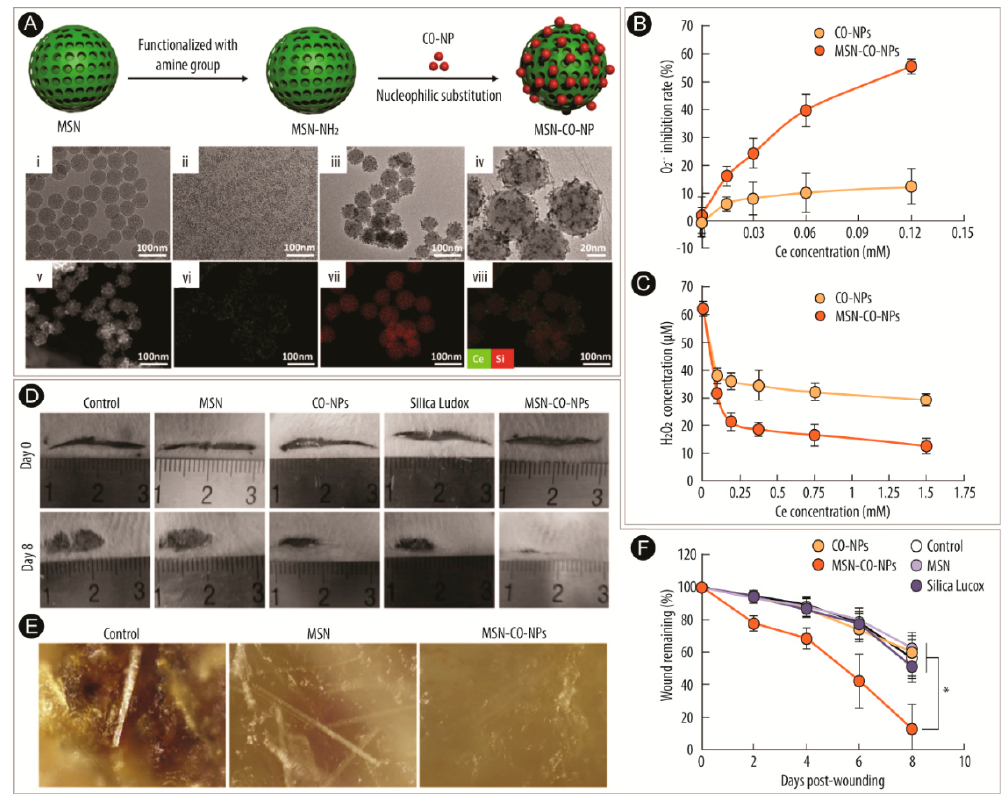
Figure 7. Cerium-oxide nanoparticle (CO-NP)-decorated mesoporous silica nanoparticles (MSNs) for reactive oxygen species (ROS) scavenging in regenerative wound healing. Fabrication process of the MSN-CO-NPs ( A ), with TEM images of MSN (i), CO-NPs (ii), and MSN-CO-CPs (iii), high-resolution TEM images of MSN-CP-NPs (iv), scanning TEM (STEM) image of MSN-CO-NPs (v), and energy-dispersive X-ray spectroscopy (EDX) element mapping of Ce (green, vi), Si (red, vii), and their overlay (viii) in MSN-CO-NPs. ROS scavenging of O 2• − ( B ) and hydrogen peroxide (H 2 O 2 ) ( C ) at different concentrations. Images of wound repair during an eight-day in vivo experiment ( D ). Microstructure of wound surface 22 days post-wounding ( E ). Quantification of wound repair kinetics as a percentage of initial wound length ( F ); * p < 0.05. Reprinted with permission from Reference [170]. Copyright 2017, Elsevier Ltd.